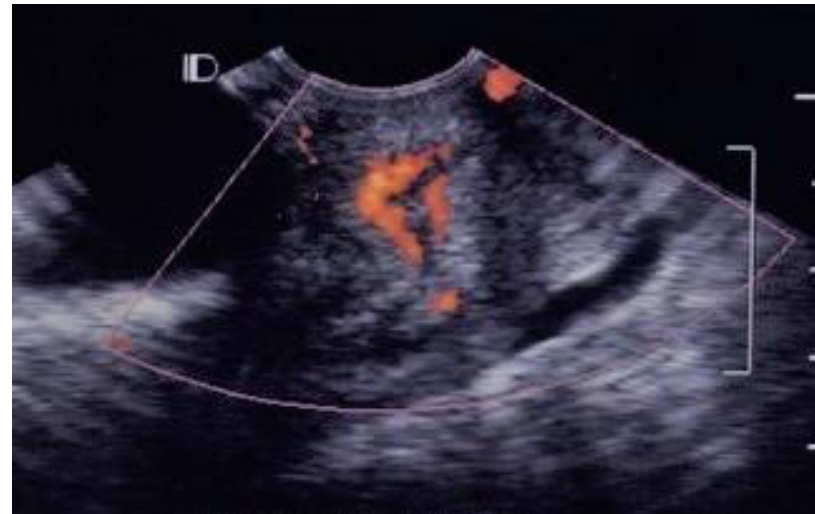
Figure 3. GRADE 3. A case of 22 years old young lady with pelvic inflammatory disease and right ovarian cyst, many vascular spots involved the endocervical canal, without involved whole endocervix.